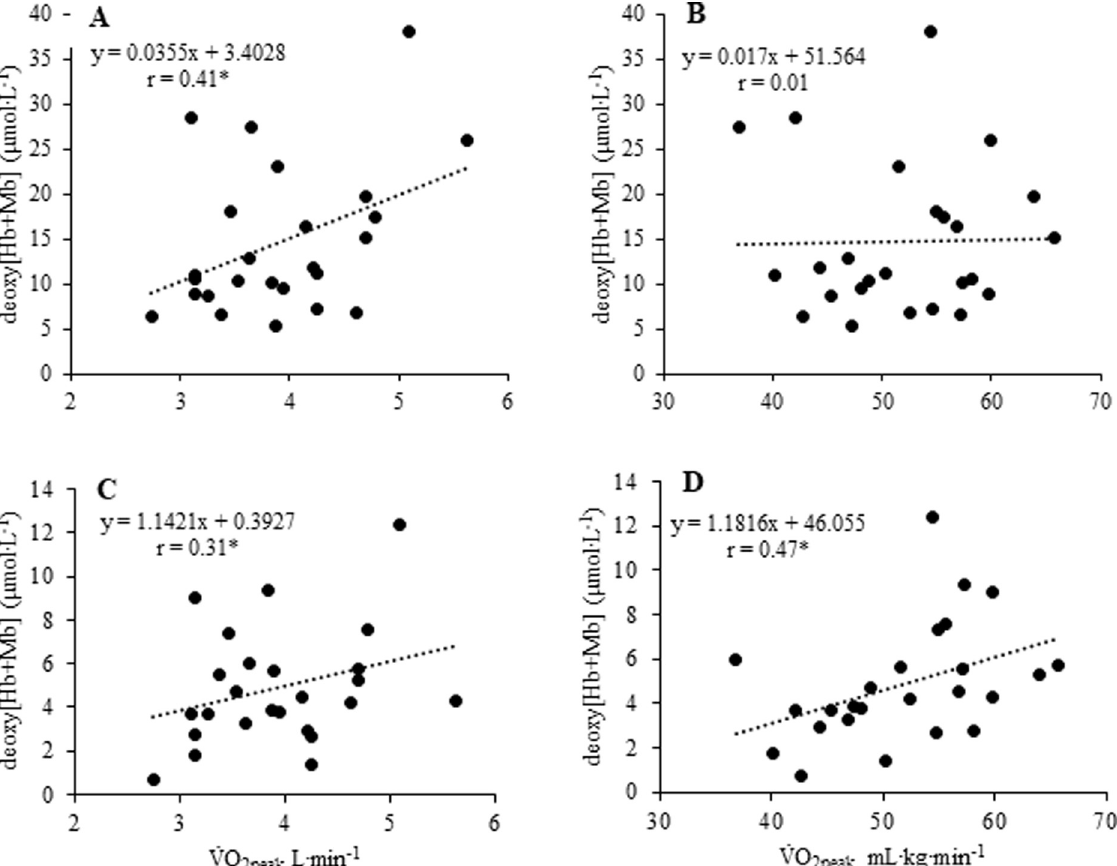
Fig 3. Relationship of the amplitude of NIRS-derived deoxyhemoglobin concentration (deoxy[Hb+Mb]) ( μ mol � L -1 ) signal with V : O 2peak (absolute and relative values). PANEL A) Absolute V : O 2peak vs amplitude from bsln to deoxy[Hb+Mb] PLATEAU ; PANEL B) Relative V : O 2peak vs amplitude from bsln to deoxy[Hb+Mb] PLATEAU ; PANEL C) Absolute V : O 2peak vs amplitude from deoxy[Hb+Mb] PLATEAU to LBF OCC 2; : O PANEL D) Relative V 2peak vs amplitude from deoxy[Hb+Mb] PLATEAU to LBF OCC 2. ( � , significant correlation, p < 0.05).